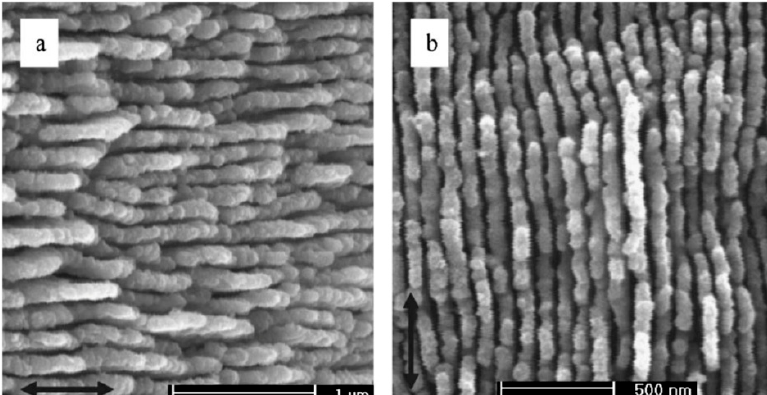
Figure 3. SEM micrographs of 6H-SiC after pulsed laser irradiation. ( a ) Surface morphology after irradiation with 500 consecutive pulses at 800 nm. ( b ) Surface morphology after irradiation with 500 consecutive pulses at 400 nm. Reproduced with permission from Ref. [58]. Copyright 2006 American Institute of Physics.